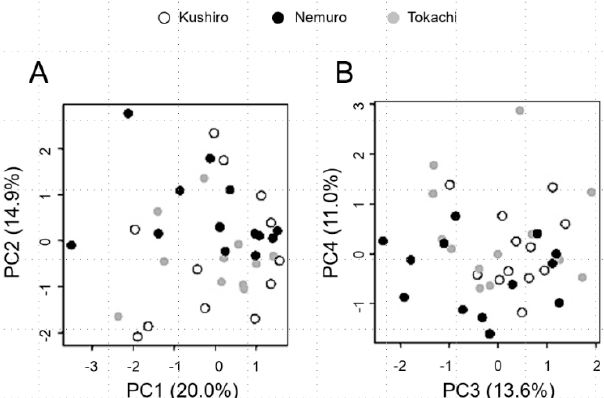
Figure 1. Principal component analysis of InDel genotypes in three populations of Kushiro, Nemuro and Tokachi. ( A ) Biplot of the first and second principal component scores (PC1 and PC2). ( B ) Biplot of the third and fourth principal component scores (PC3 and PC4). Sampling locations are shown by colors: Kushiro (white circles), Nemuro (black circles) and Tokachi (grey circles). Values in parentheses are the contribution ratios of each principal component. Thirteen red-crowned crane chicks were selected from Kushiro, Nemuro and Tokachi in eastern Hokkaido, respectively.